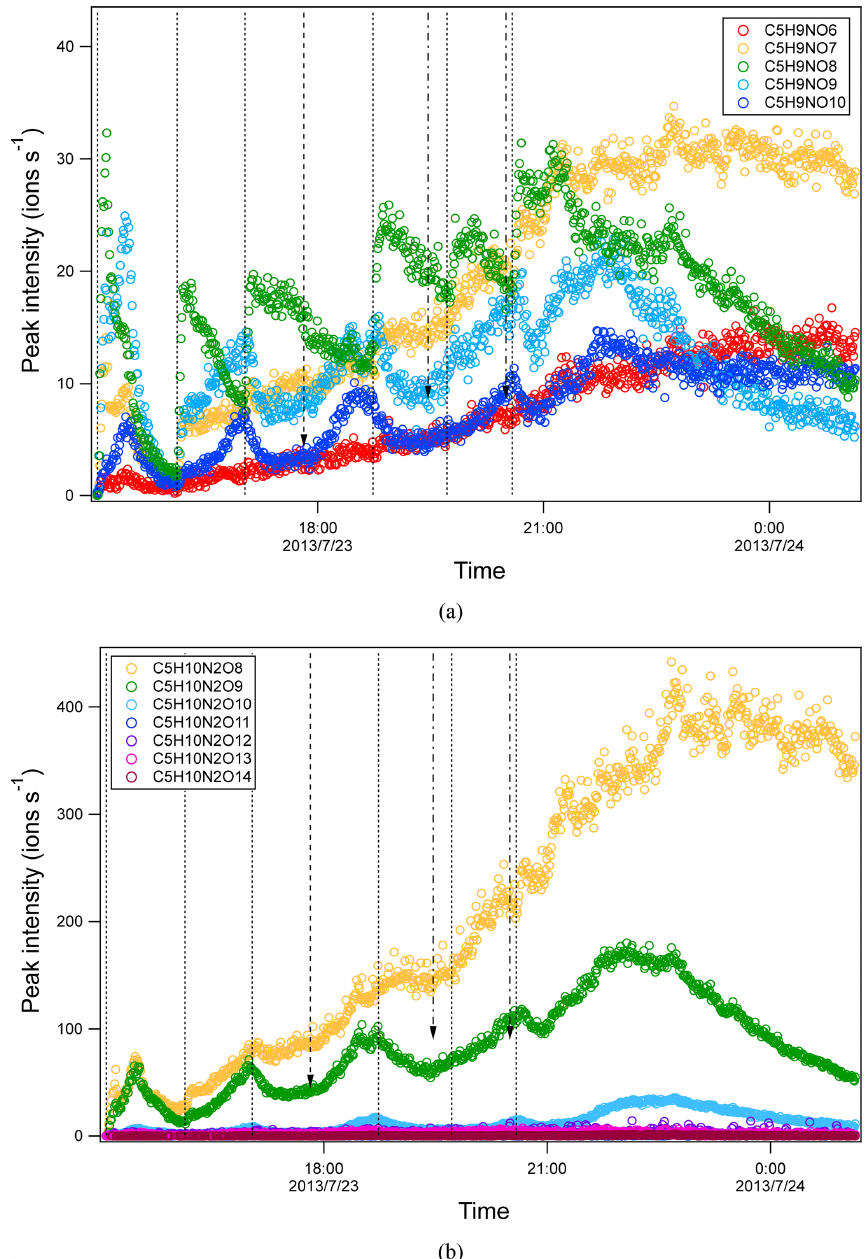
Figure 3. Time series of peak intensity of several HOM monomers of C 5 H 9 NO n series (a) and of C 5 H 10 N 2 O n series (b) . They are likely (cid:113) (cid:113) the termination products of RO 2 C 5 H 8 NO n and C 5 H 9 N 2 O n , respectively. The dashed lines indicate the time of isoprene additions. The long-dashed arrow indicates the time of NO 2 addition. The dash-dotted arrows indicate the time of O 3